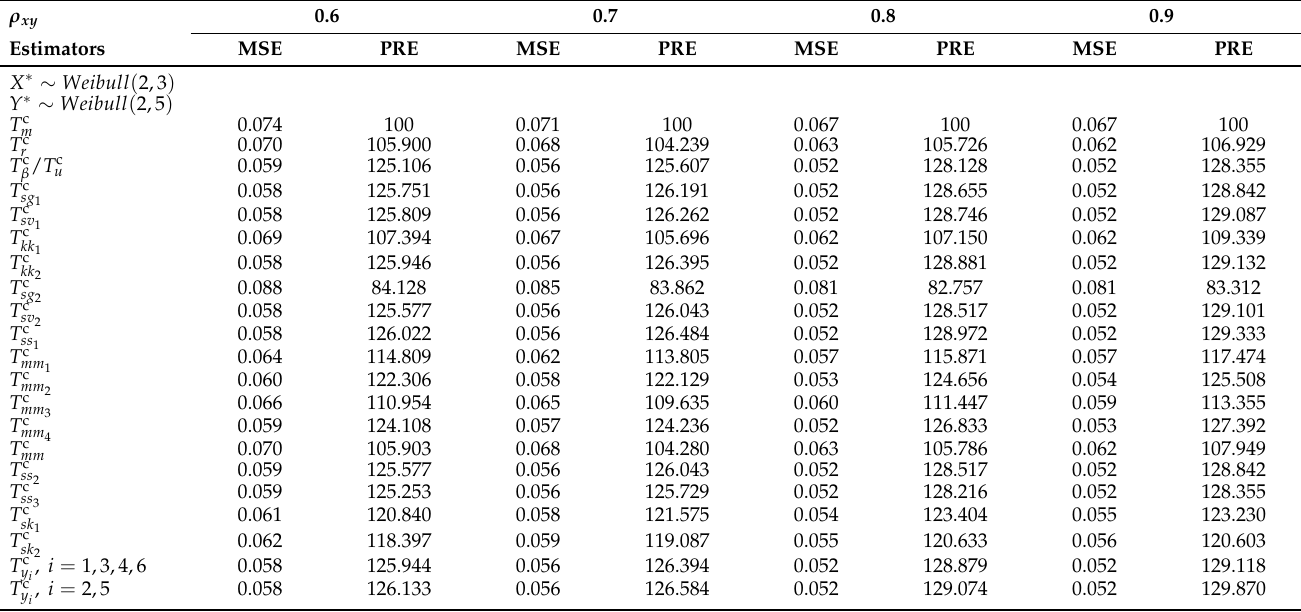
Table 5. MSE and PRE of combined estimators utilizing hypothetically drawn Weibull population.